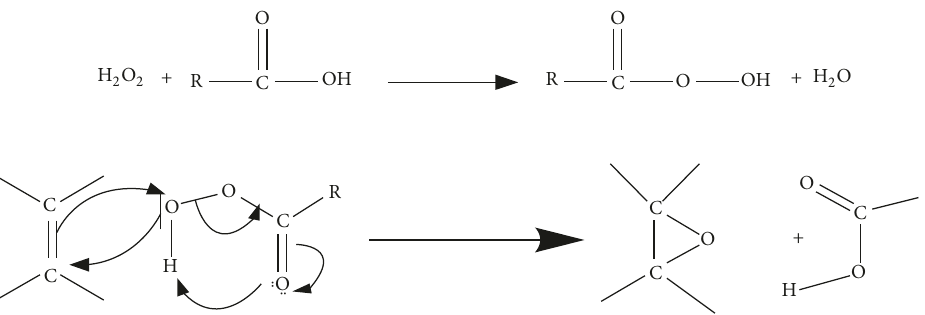
Figure 1: Mechanism of epoxidation reaction for vegetable oil